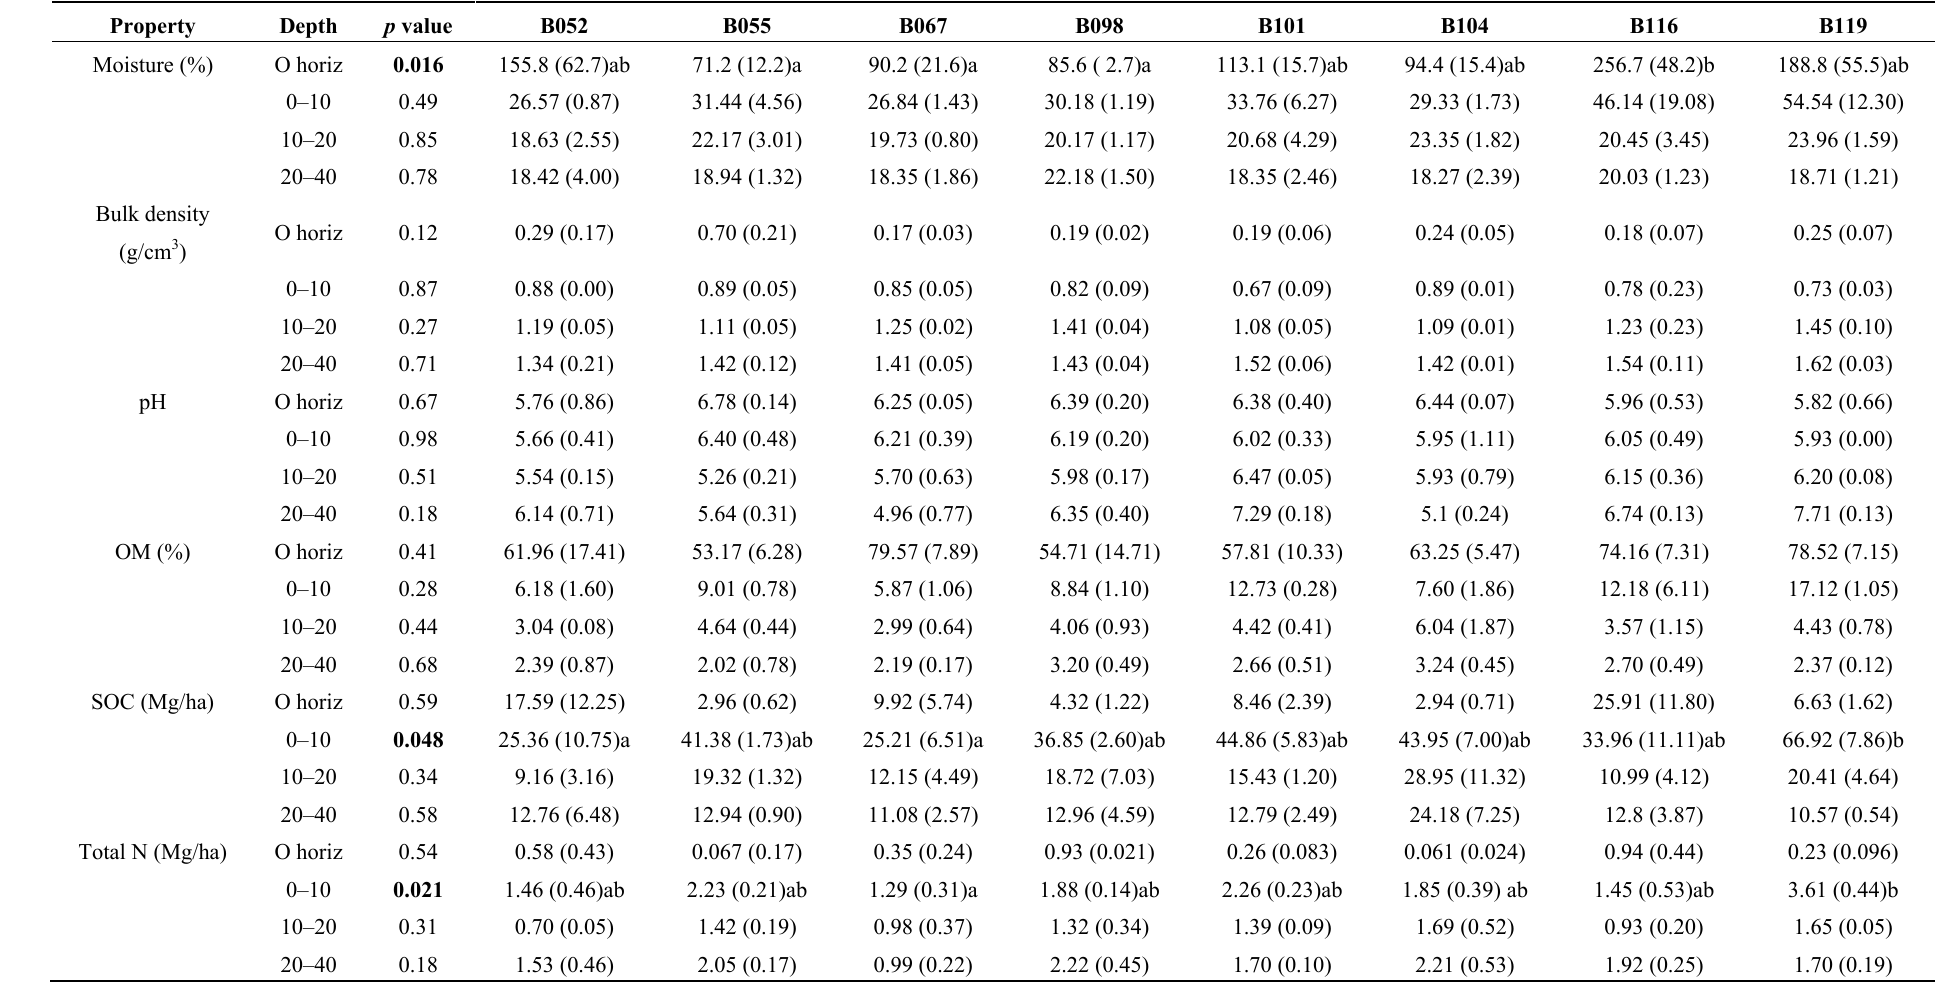
Table 2. Ecosite class averages (standard errors) by